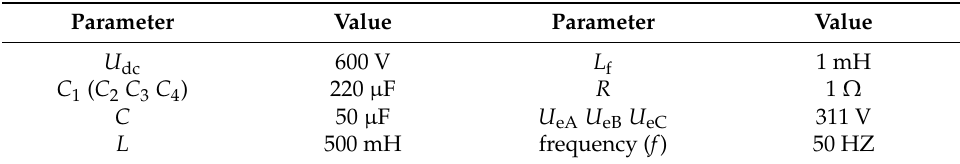
Table 1. Simulation parameters.